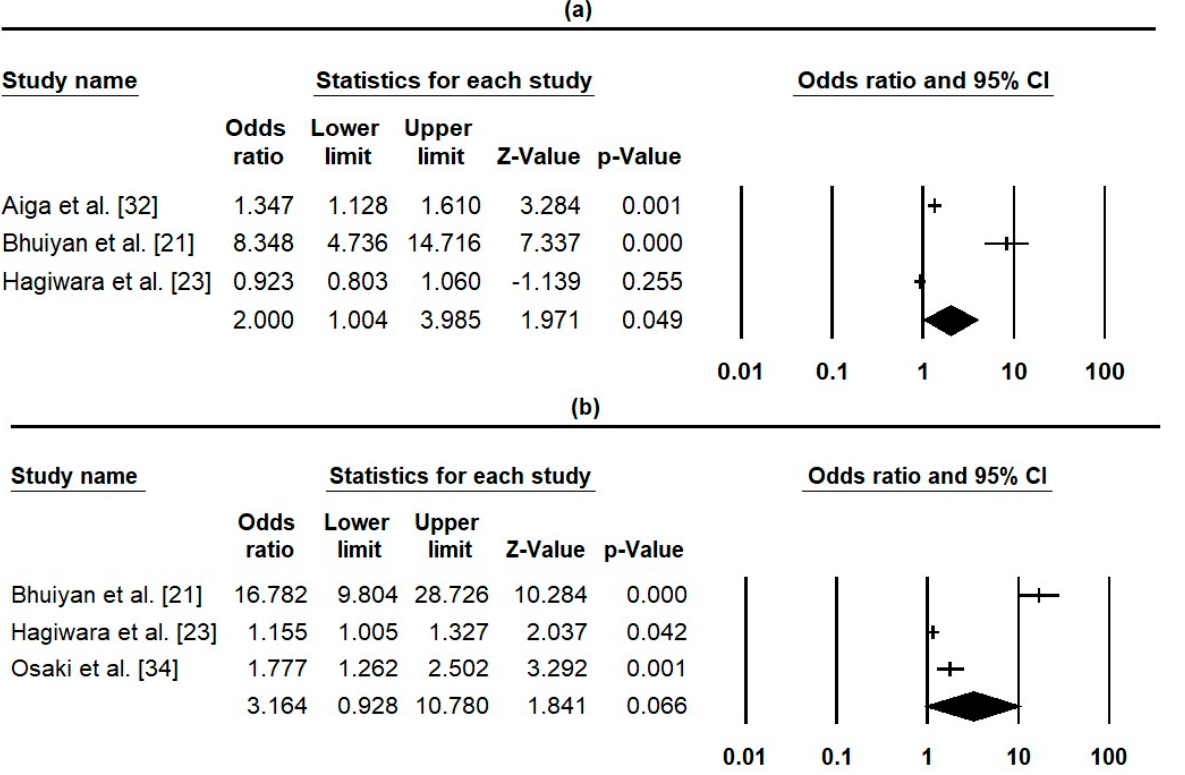
Figure 3. Forest plot of PHCHR effect on Parent Health Knowledge: ( a ) Breast Feeding (Heterogeneity: Q-value = 59.73, p = 0.00, I 2 = 96.65), ( b ) Pregnancy danger signs (Heterogeneity: Q-value = 91.27, p = 0.00, I 2 = 97.81).